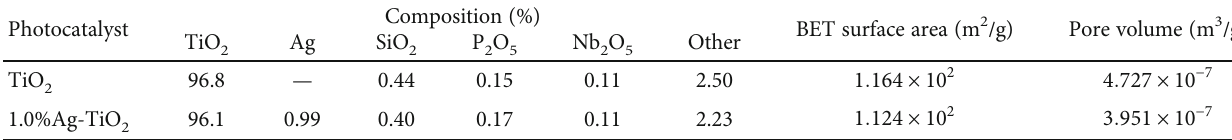
and 1.0%Ag-TiO 2